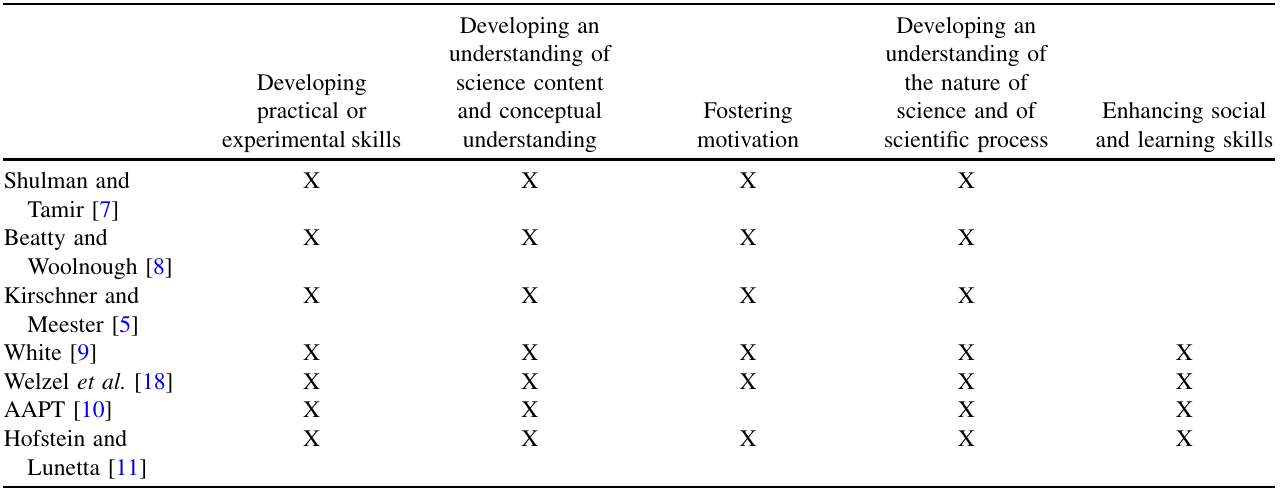
TABLE I. The main objective categories of practical work formulated by different